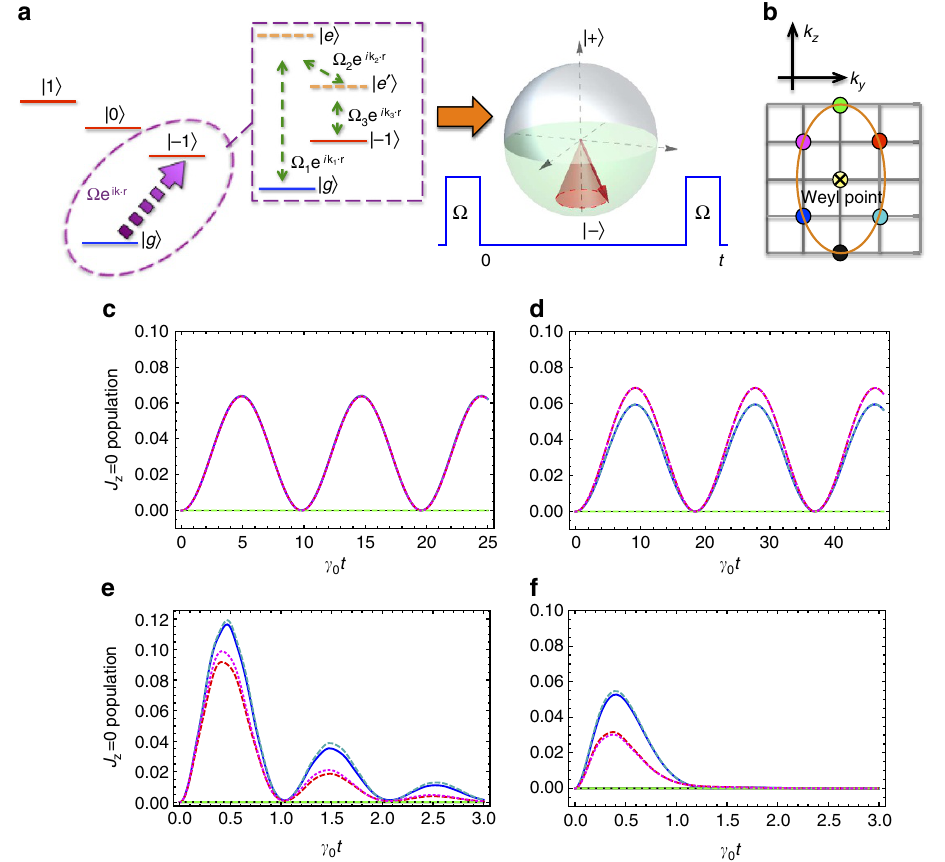
Figure 4 | Observation of Weyl quasiparticles. ( a ) Momentum-selective Ramsey spectroscopy: interfering Raman beams create an excitation with the angular-momentum projection J z ¼ (cid:3) 1 and with translational momentum k near the Weyl node (see text). After a waiting time t the second pulse is applied to measure the fraction of particles in the J z ¼ 0 angular-momentum state. ( b ) Six quasimomenta near the Weyl node. ( c ) The fraction of particles in the J z ¼ 0 state oscillates as a function of time t with the frequency ( E 1 quasiparticle dispersion. ( d ) The oscillations in the presence of dissipation for k 0 a (cid:9) 0 : 5. ( e ) The oscillations in a 99% randomly filled lattice. ( f ) The oscillations in a 93% filled lattice. For ( c , d ) a 3D cubic lattice of 100 (cid:6) 100 (cid:6) 100 sites was used and we took advantage of the translational symmetry. For ( e , f ) a 3D cubic lattice of 10 (cid:6) 10 (cid:6) 10 was